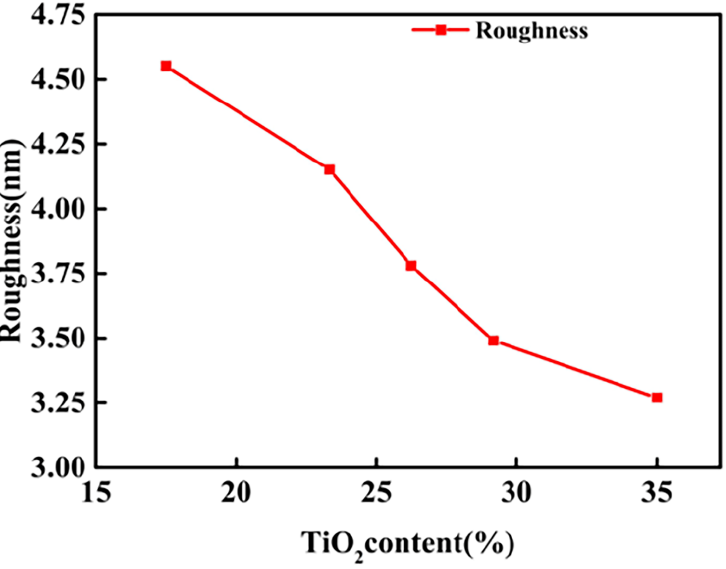
Figure 13. Roughness of coatings with different titanium content.